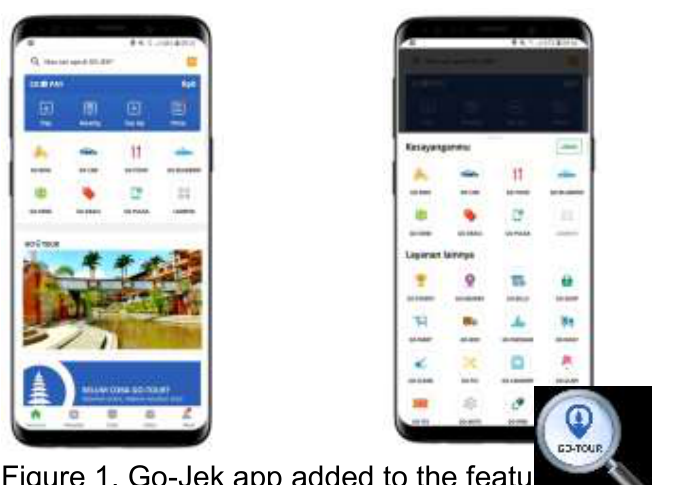
Figure 1. Go-Jek app added to the feature.